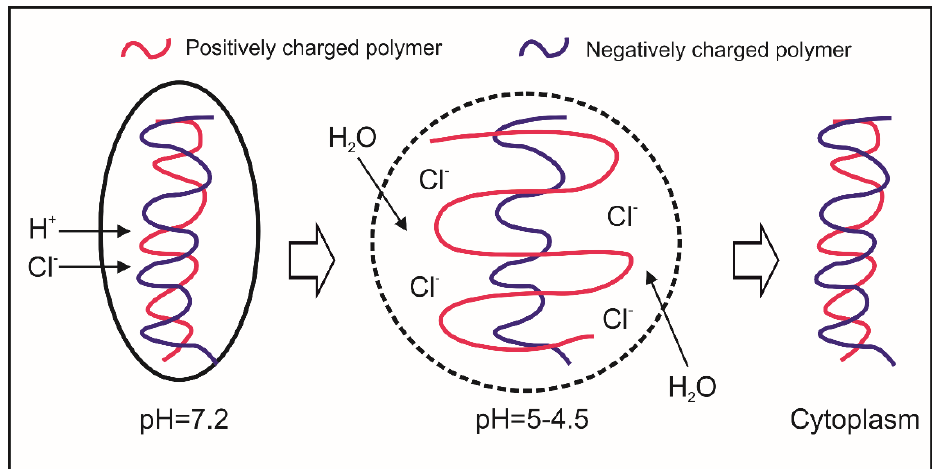
Figure 3. The ‘proton sponge’ hypothesis: H + and Cl − enter into the endosome, lead to osmotic swelling and finally to the endosome breakage.